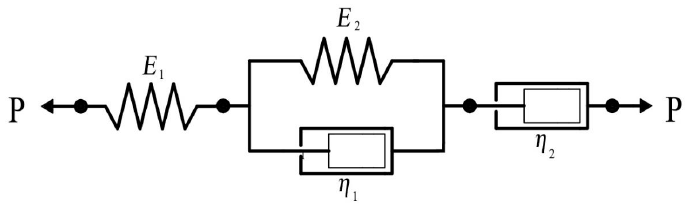
Figure 11. The pressure–sinkage constitutive model of deep-sea